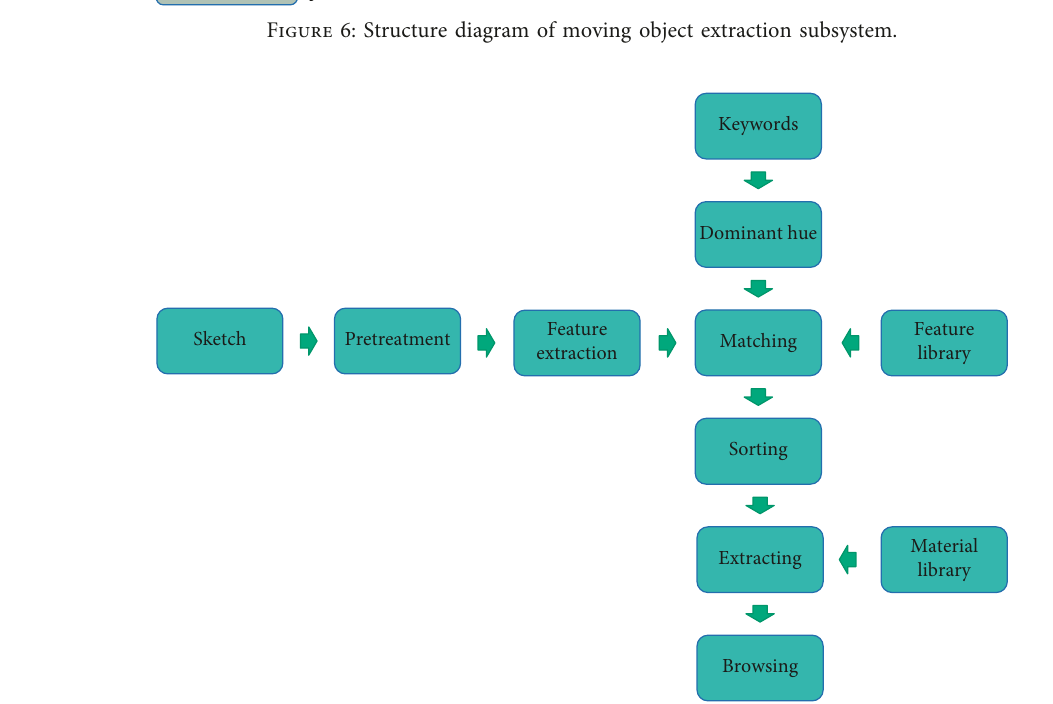
Figure 7: Video material retrieval subsystem structure diagram.